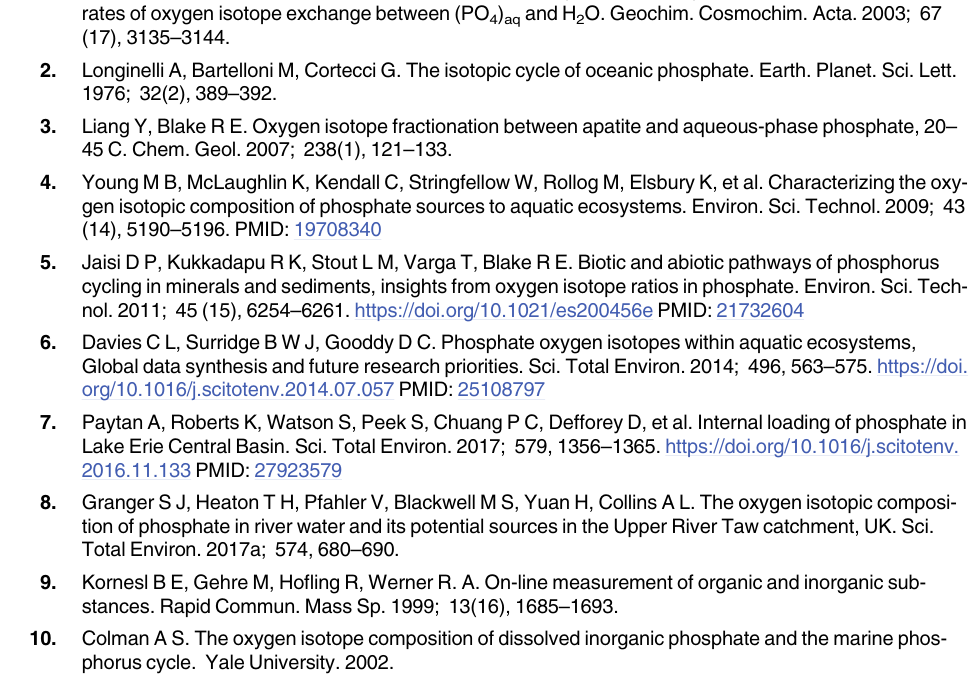
PO through all the tech- 2 4 PO . (d): Std (Ag PO 2 4 3 4